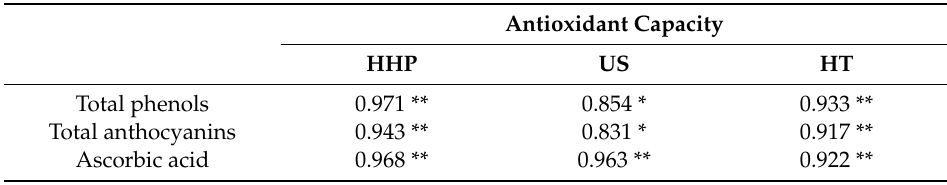
Table 3. Pearson correlation of total phenols, total anthocyanins, ascorbic acid, and antioxidants in juice blends treated with HHP, US, and